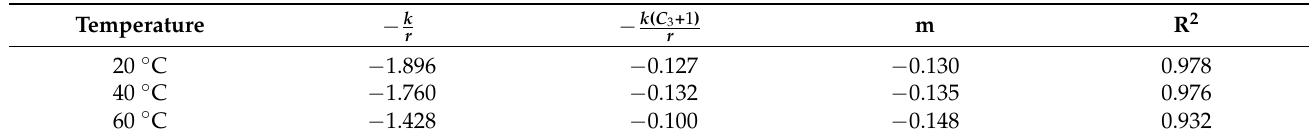
Table 7. Verification analysis of parameters m and C 3 .